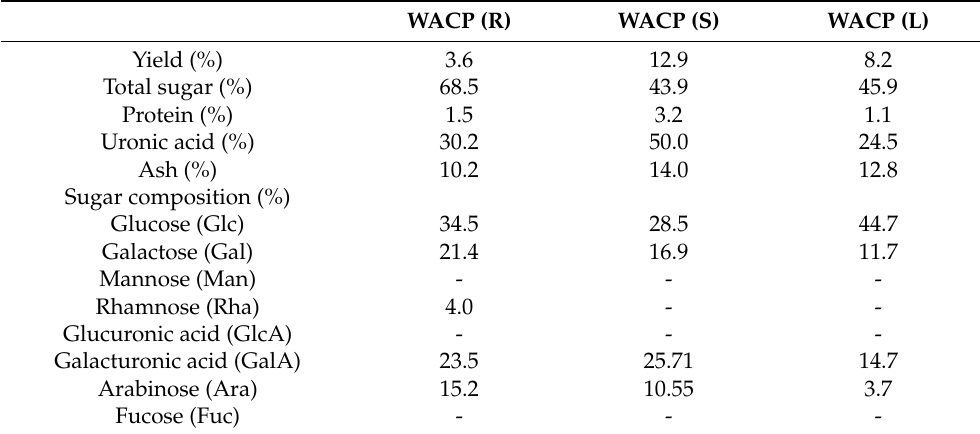
Table 1. Chemical characteristics and monosaccharide composition of the polysaccharides extracted from three different tissues of Aralia continentalis